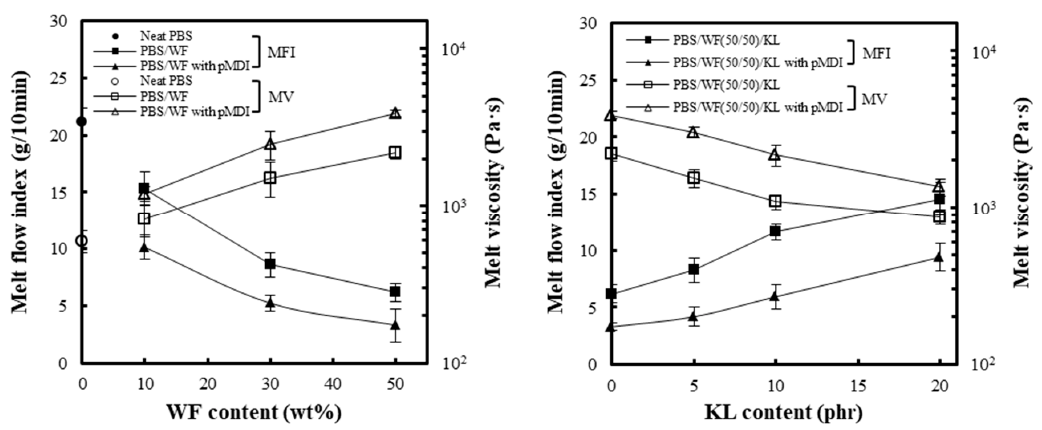
Figure 6. Melt flow index (MFI) and melt viscosity (MV) of PBS/WF composites with varying WF and KL contents.